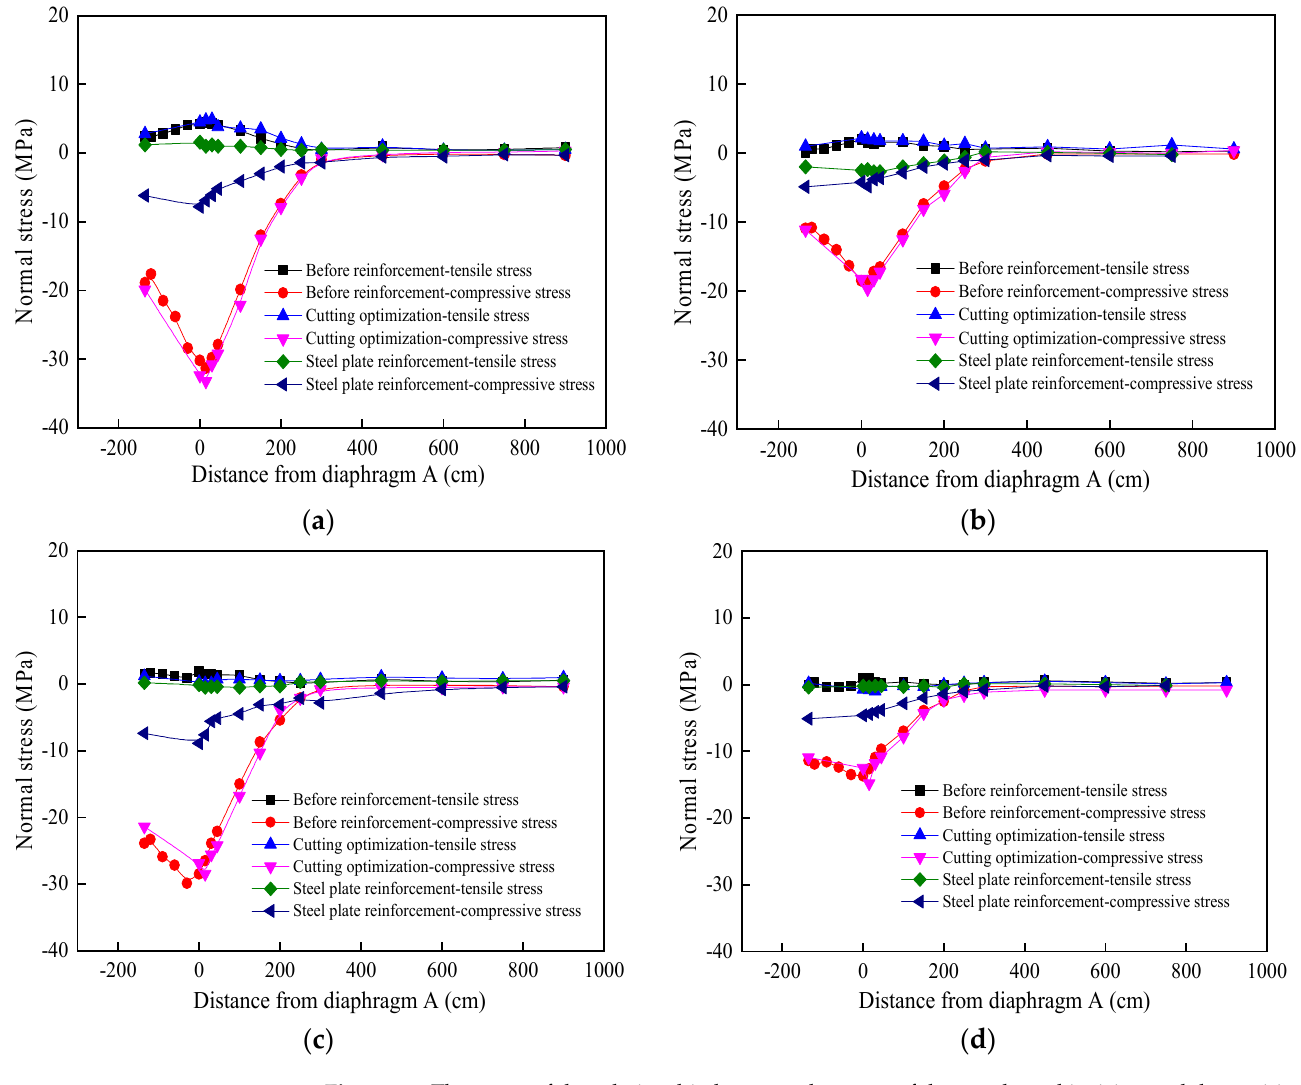
Figure 20. The curve of the relationship between the stress of the arc-shaped incision and the position of the longitudinal load: ( a ) A# measuring point, ( b ) B# measuring point, ( c ) a# measurement point, ( d ) b# measuring point.